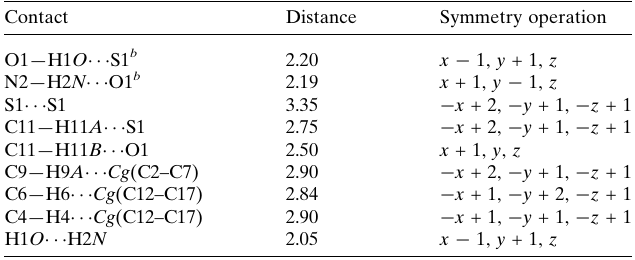
Table 2. These hydrogen bonds are also reflected in the Hirshfeld surface mapped over the electrostatic potential shown in Fig. 3( b ), where the positive electrostatic potential (blue) and negative electrostatic potential (red) regions are observed around the amine-H2 N and thione-S1 atoms, respectively. The faint red spots appearing near the thione-S1, hydroxyl-O1 and methylene-H11 A and H11 B atoms (Fig. 4)